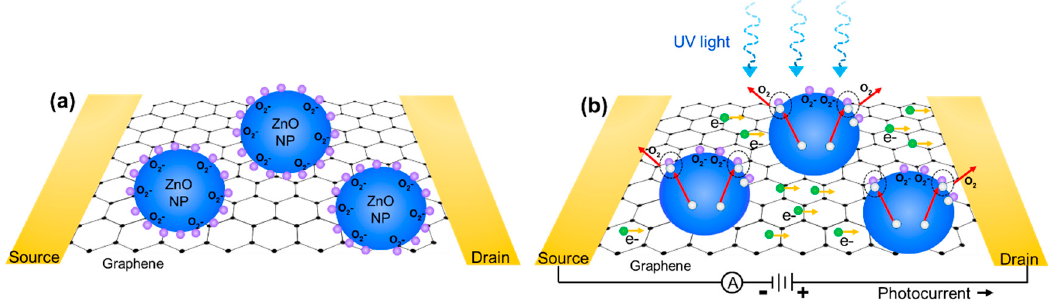
Figure 5. Schematic of photoconduction mechanism for ZnO nanoparticle / graphene photodetectors ( a ) without and ( b ) with UV illumination (not to scale).